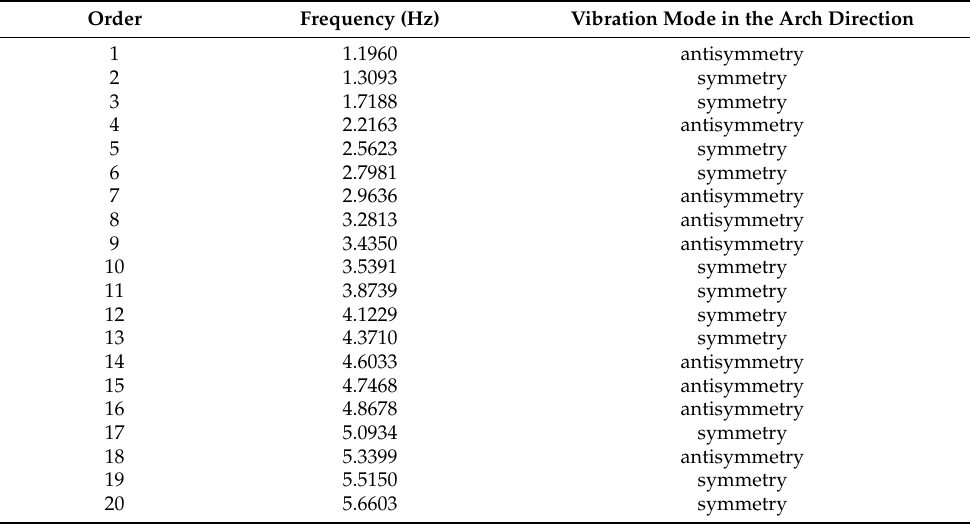
Table 2. The first 20 order frequencies and the corresponding vibration